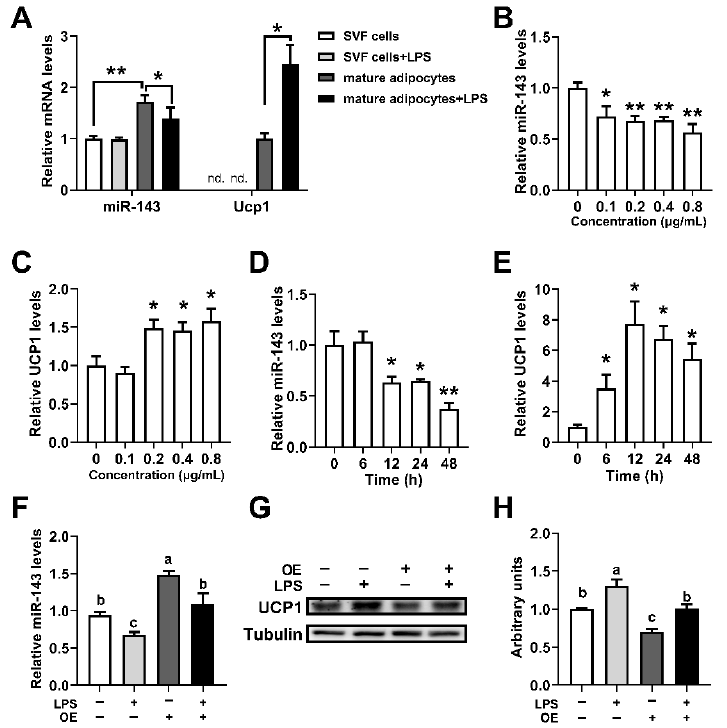
Figure 2. miR-143 was negatively correlated with the expression of inflammatory factors in the BAT. ( A , B ) Correlation between miR- 143 expression and TNFα ( A ) or IL-6 ( B ) in the BAT of mice fed HFD for 0, 1, 3, 7, 14, 21 days (n = 48 and 28). ( C , D ) Correlation between miR- 143 expression and TNFα ( C ) or IL-6 ( D ) in primary brown adipocytes treated with 0.2 μg /mL LPS for 0, 12, 24, 48 h (n = 28). The correlation between miR-143 and IL- 6 or TNFα was analyzed by GraphPad Prism 9.0.